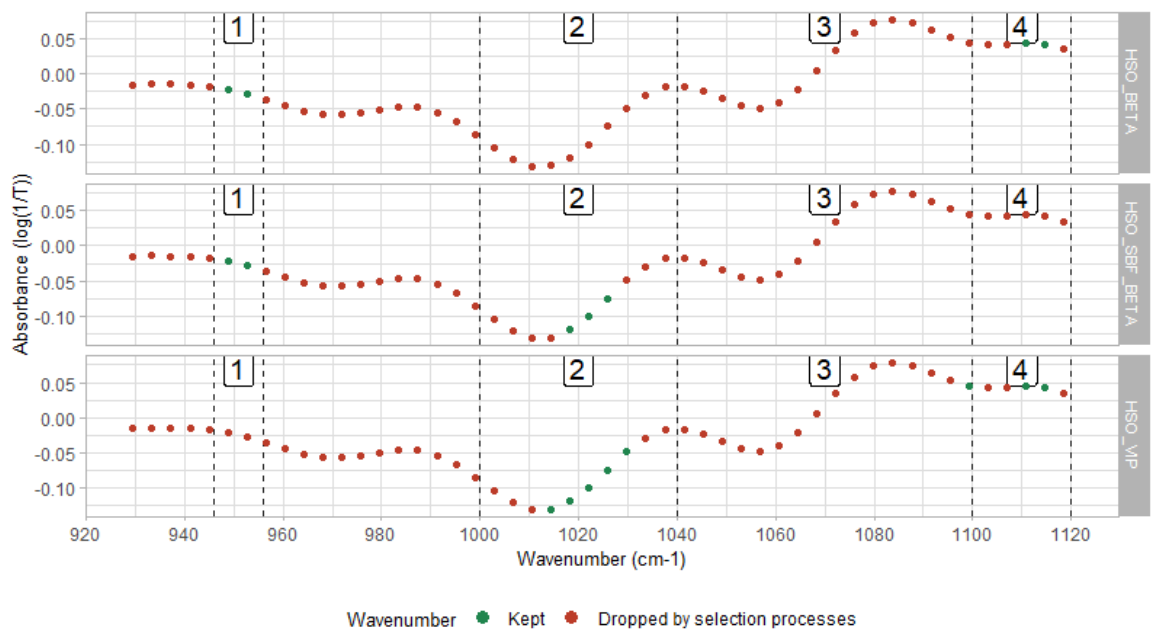
Figure 2. Spectral representation of the 3 models providing the best RMSE of validation.